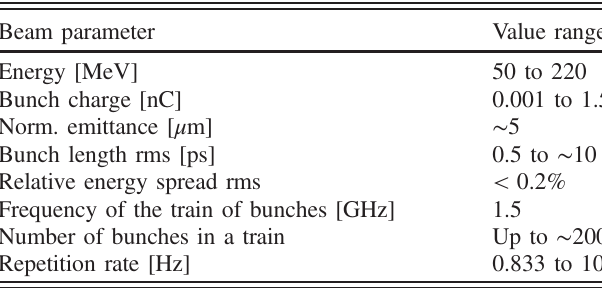
TABLE II. Beam parameters at the end of CALIFES. Beam parameter